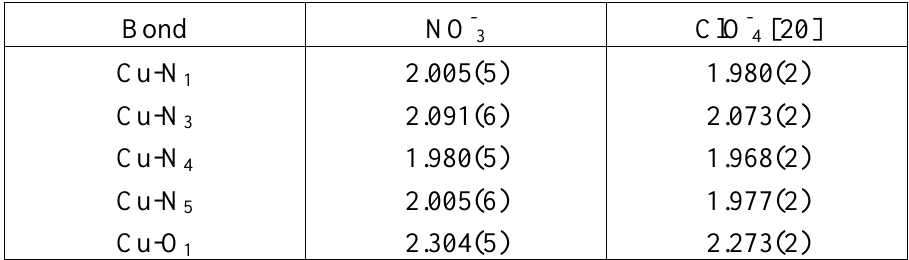
Table 1: Selected Cu-N and Cu-O bond distances (Å) for CuLL